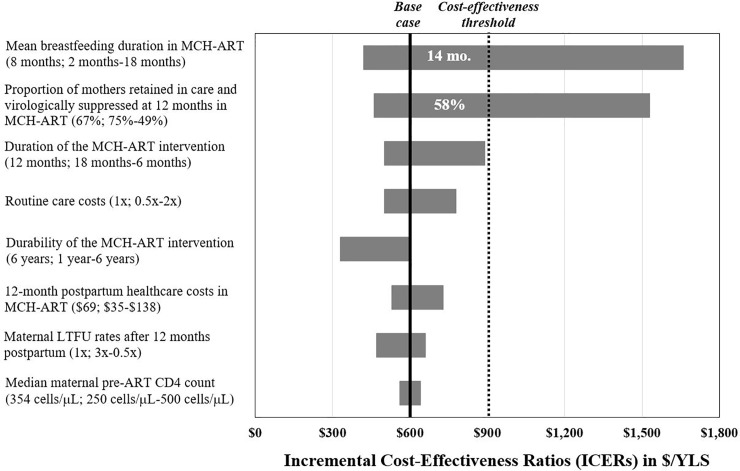
Tornado diagram of one-way sensitivity analyses.Results of one-way sensitivity analyses of 8 key model input parameters (vertical axis) are shown. The ICER ($/YLS) of MCH-ART compared to SOC is displayed along the horizontal axis. Base case inputs for each varied parameter are listed prior to the semicolon; after the semicolon is the range examined with the first value indicating the value of the left-most part of the bar. Parameters were varied through the range listed (S2 Table details rationale for ranges), with the input that contributes to the lowest ICER for the range listed first. The thick black vertical line marks the base case ICER ($599/YLS). The dotted line represents the cost-effectiveness threshold ($903/YLS; see text). Numbers in white reflect the value at which parameters crossed the cost-effectiveness threshold. ICER: incremental cost-effectiveness ratio; ART: antiretroviral therapy; LTFU: loss to follow-up; YLS: year of life saved.